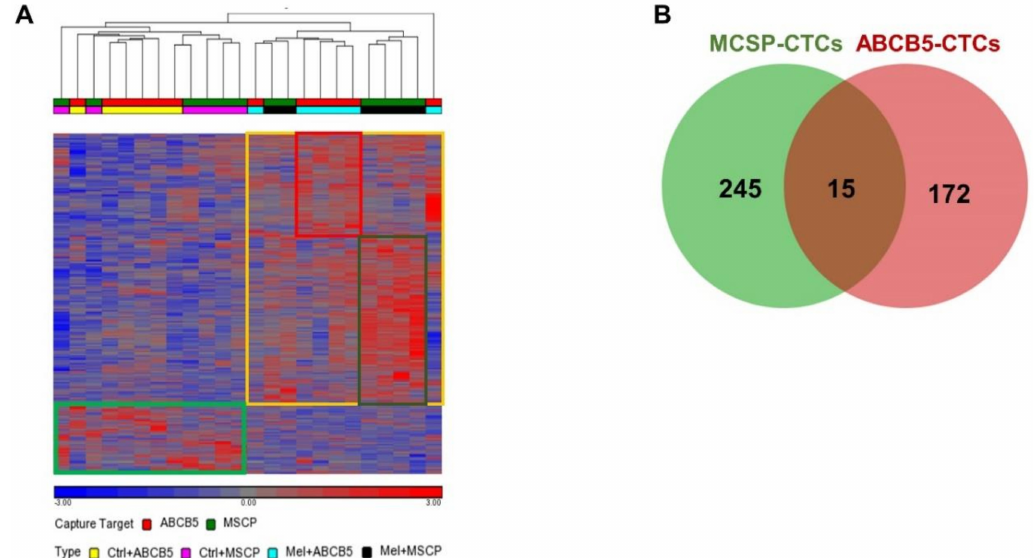
Figure 2. MCSP and ABCB5 CTCs have distinctive gene expression patterns. ( A ) Unsupervised hierarchical clustering analysis of differentially expressed genes between CTC fractions enriched from samples of healthy donors ( N = 6) and melanoma patients ( N = 6) using immunomagnetic beads targeting MCSP or ABCB5. Each row is a single gene and each column is a single sample. Red indicated up-regulation and blue indicates down-regulation according to the colour scale at the bottom. The squares indicate the genes that were up-regulated in melanomas (yellow box) and in controls (light green box). Genes that are differentially expressed (with ANOVA p < 0.05 and fold difference 2 vs. respective controls) in either cell type (MSCP or ABCB5 CTCs) were used to perform an unsupervised hierarchical clustering. This analytical approach discriminated the gene expression patterns from MCSP- (dark green box) and ABCB5-enriched (red box) CTC fractions. ( B ) Comparison of up-regulated genes between MCSP- (green circle) and ABCB5-enriched (red circle) CTC fractions found only 15 genes shared between these two CTC